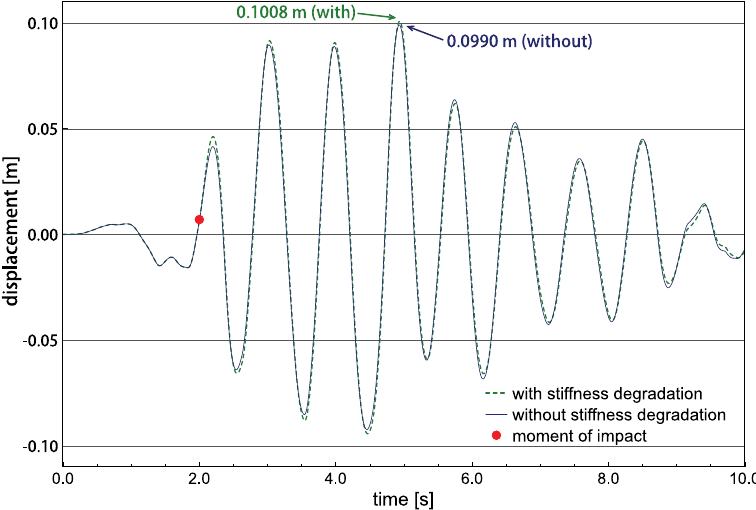
Fig. 6. Displacement time history of the first story of building under the El Centro earthquake with and without considering the degradation of horizontal stiffness for impact at t = 2